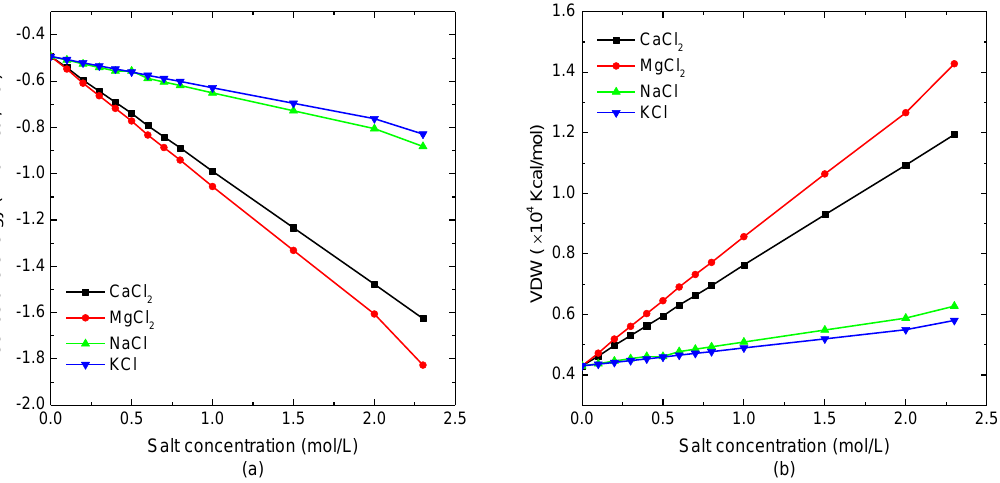
Figure 1. The non-bonded interactions of the protein system versus the external salt concentration. ( a ) Electrostatic potential energy and ( b ) van der Waals energy.